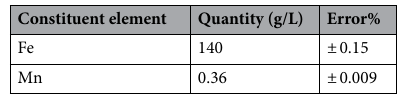
Table 1. Chemical composition of the WPL.